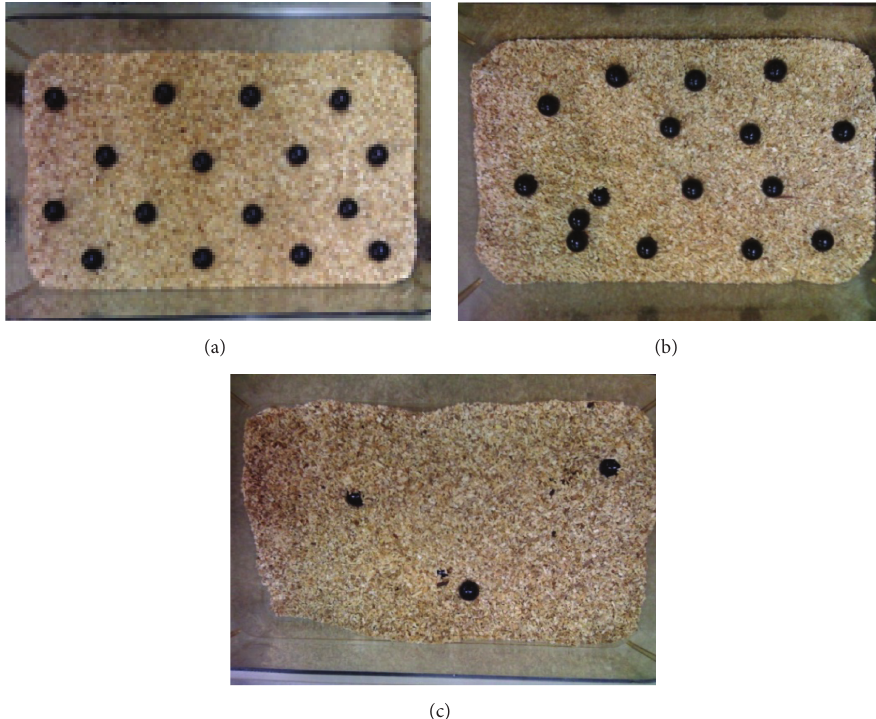
Figure 1: Marble-burying apparatus. (a) Marble-burying apparatus ready for use. (b) Marble-burying apparatus after use by representative VPA-treated animal. (c) Marble-burying apparatus after use by representative normal control animal.